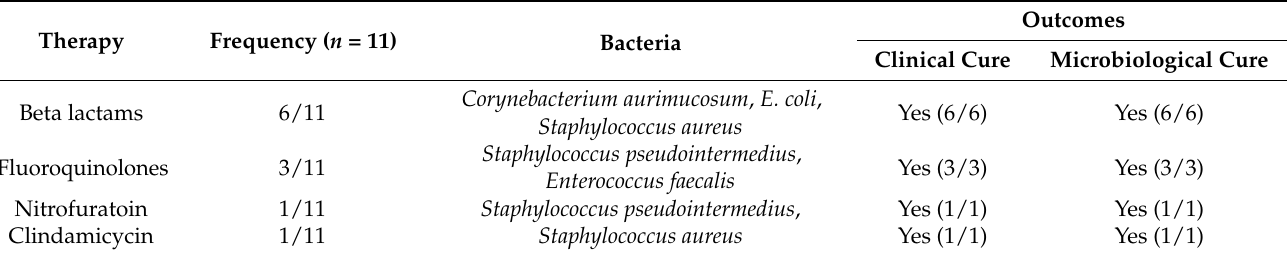
Table 4. Table summarizes drugs used to treat cats according to results of susceptibility test, frequency of different treatments considering total number of enrolled cats (11), bacteria isolated in urine samples, clinical and microbiological outcomes considering number of cats that received that specific